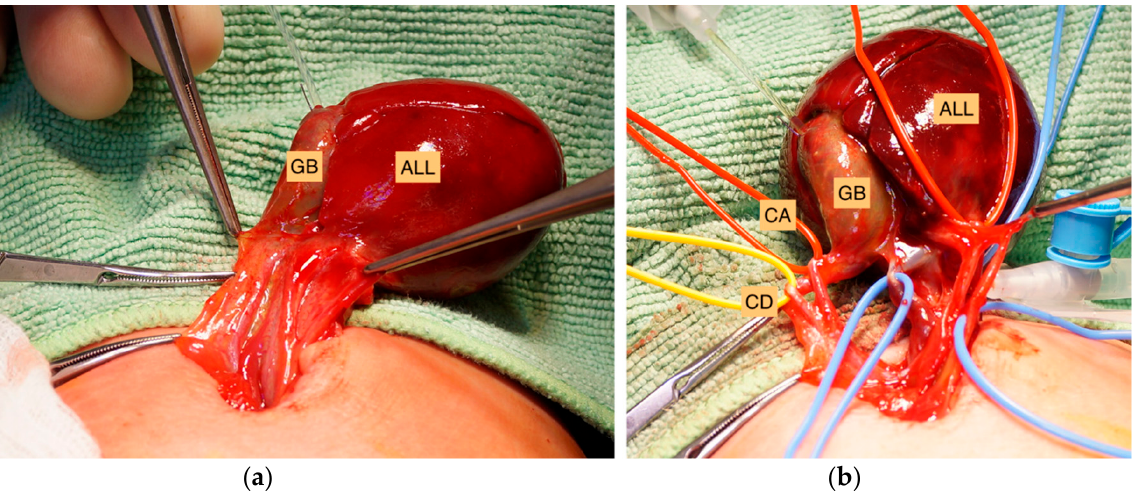
Figure 1. ( a ) A small abdominal wall defect of three centimeters in diameter and an intact hernia sac (H) were identified after birth. ( b ) Exposure of the accessory liver lobe (ALL) with embedded gallbladder (GB) after the opening of the membrane of the hernia sac (H).